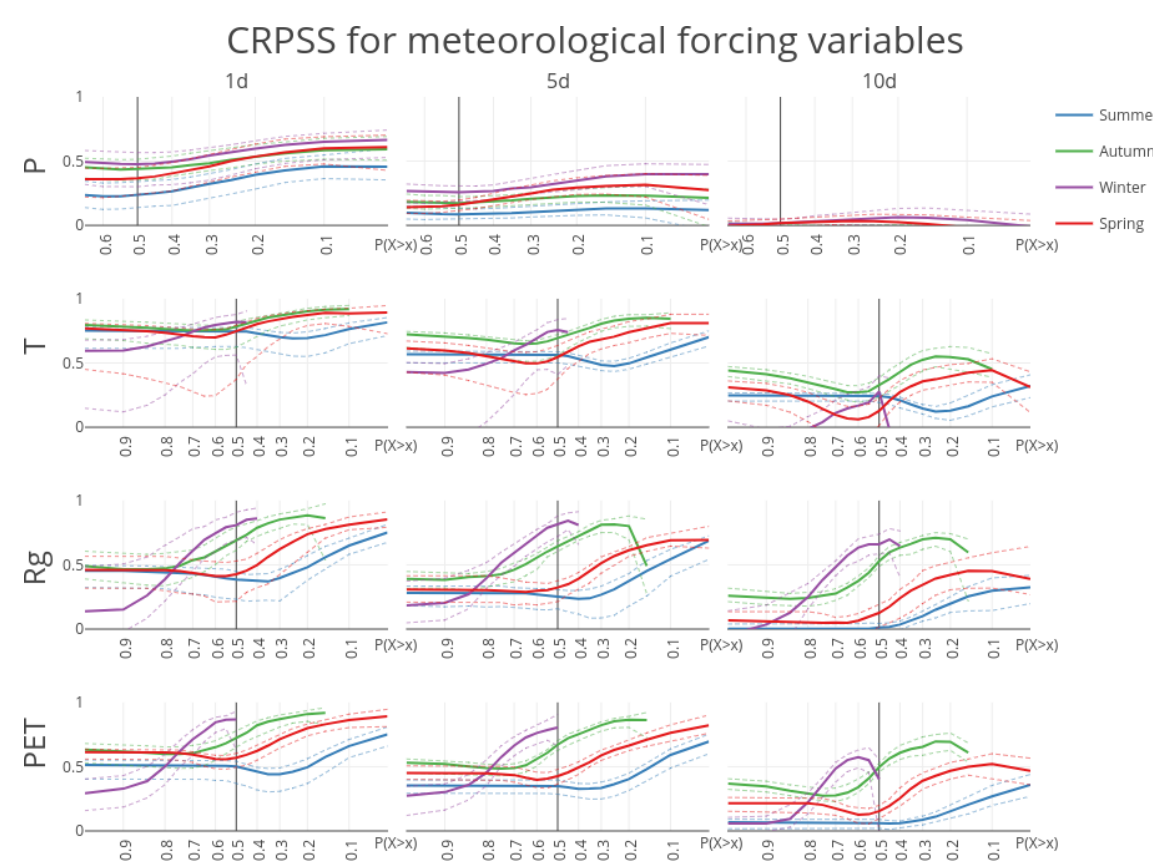
Figure 4. Continuous ranked probability skill score (CRPSS) for the four forcing variables benchmarked against sample climatology for the 148 HBV subbasins. CRPSSs are aggregated into mean (solid), 10th and 90th percentiles (dashed). Note that the CRPSS at P(X ≥ x) = 0 . 1 or 0.7 is calculated over, respectively, the 10% and 70% highest observation–forecast pairs, conditioned on the